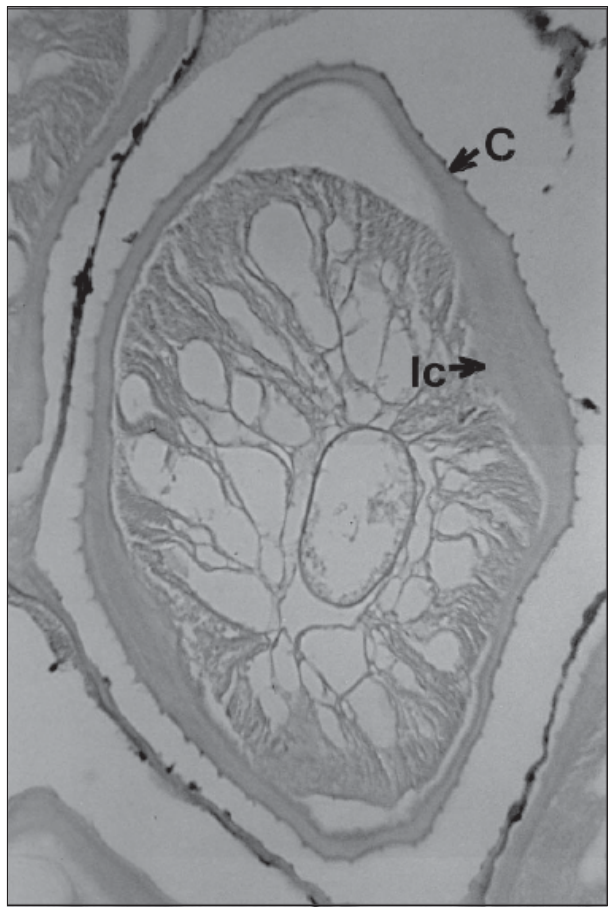
Figure 1) Hematoxylin and eosin stained section of Dirofilaria (No- chtiella) ursi-like isolate. C Cuticle; lc Lateral cord. x